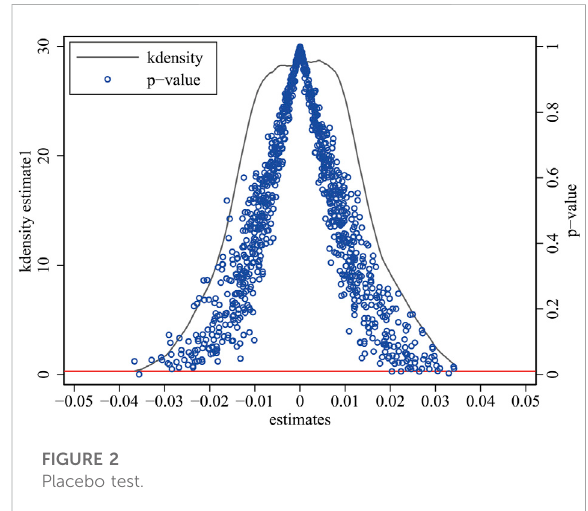
FIGURE 2 Placebo test.